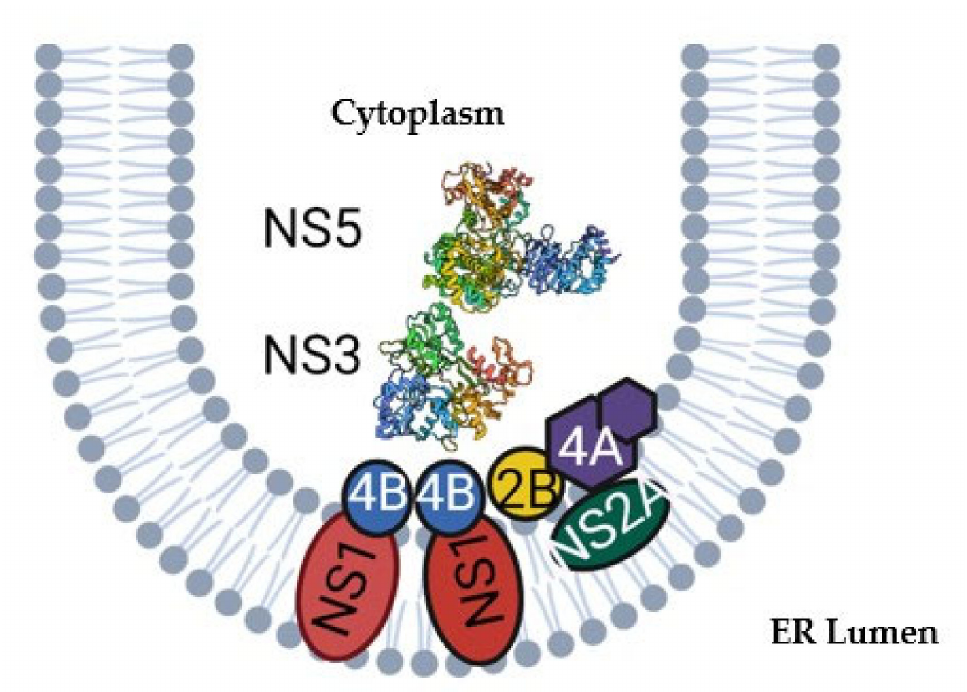
Figure 1. Flaviviral replication complex within an ER invagination. Zika NS5 and NS3 were retrieved from protein data base, codes 5TFR [35] and 5JMT [36],